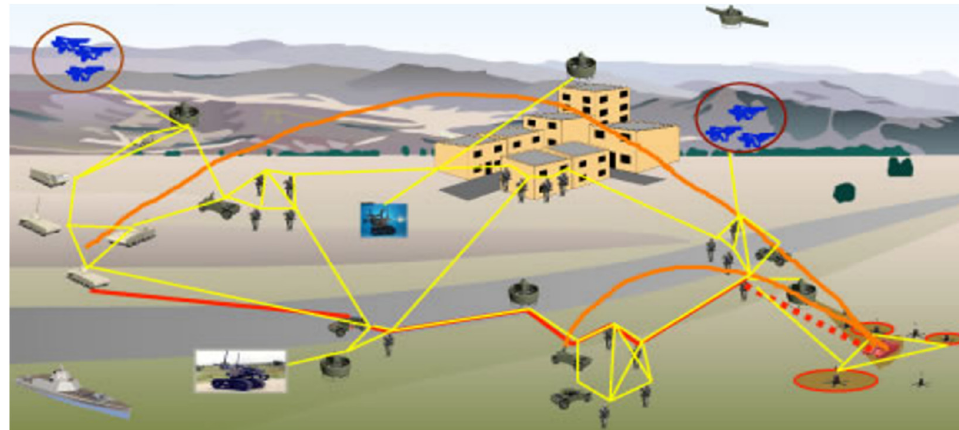
Figure 1. Military Tactical Networking.